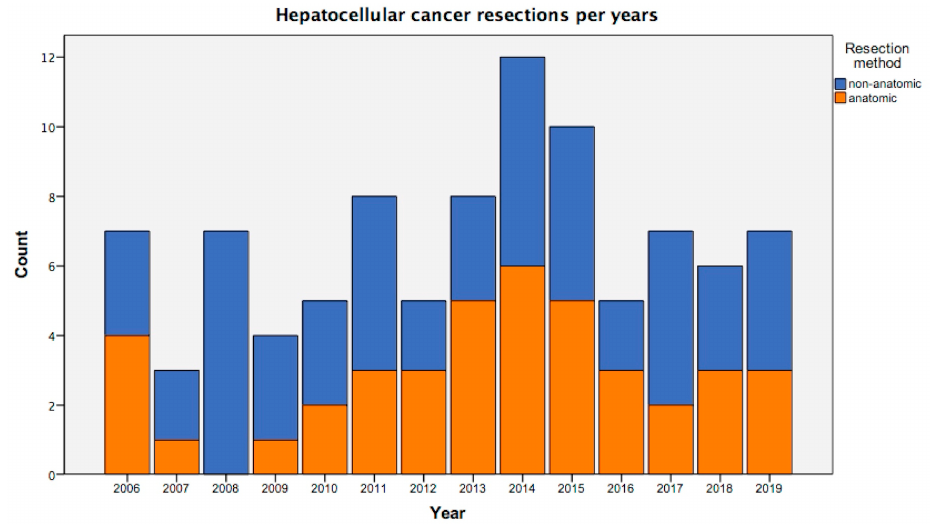
Figure 4. Number of anatomic (orange) and non-anatomic (blue) liver resections those were per- formed for the treatment of hepatocellular carcinoma at the institute by years.